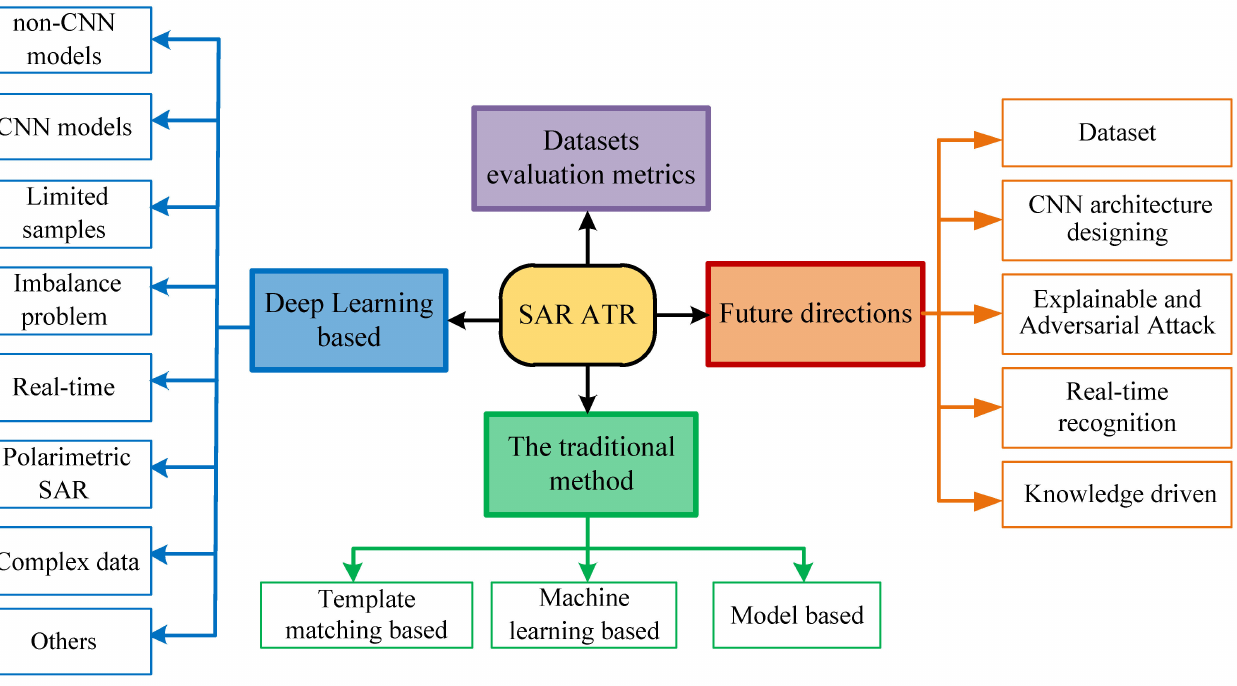
Figure 2. The framework of the